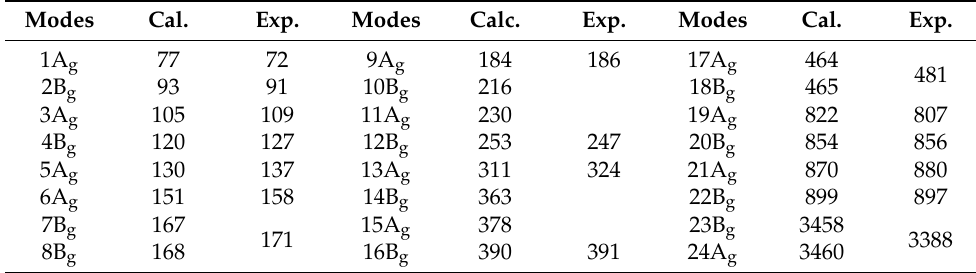
Table 1. Summarizes the theoretically calculated and the experimentally observed Raman-mode frequencies of the Cu(OH)Cl sample under study. Modes Cal.